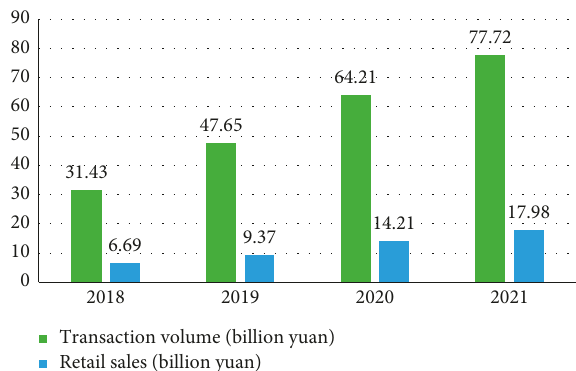
Figure 5: Online transaction volume and retail sales of a certain rural